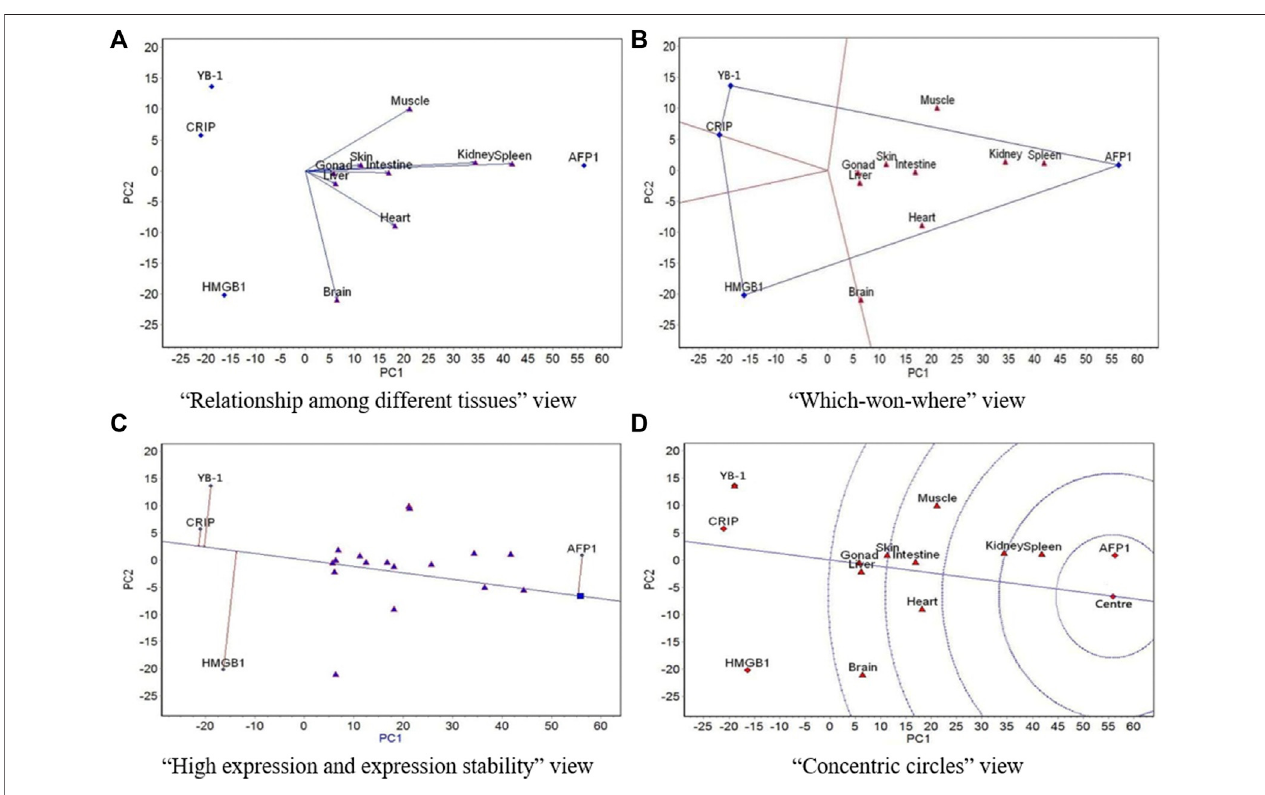
FIGURE 3 | The GGE biplot for expression of four resistance genes to low temperature (AFP1, CIRP, YB-1, and HMGB1) in different tissues at 8 ° C. (A) “ Relationship among different tissues ” view. (B) “ Which-won-where ” view. (C) “ High expression and expression stability ” view. (D) “ Concentric circles ” view.